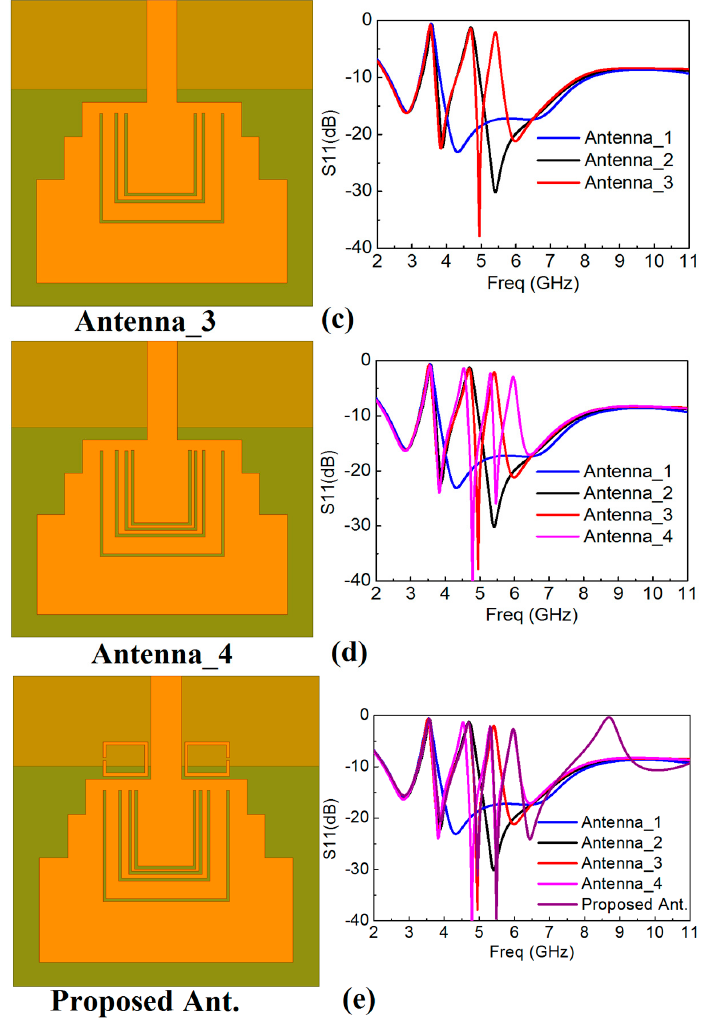
Figure 3. Design steps of the proposed antenna with the corresponding reflection coefficient results at each stage. The left column shows the antenna structure under design at different